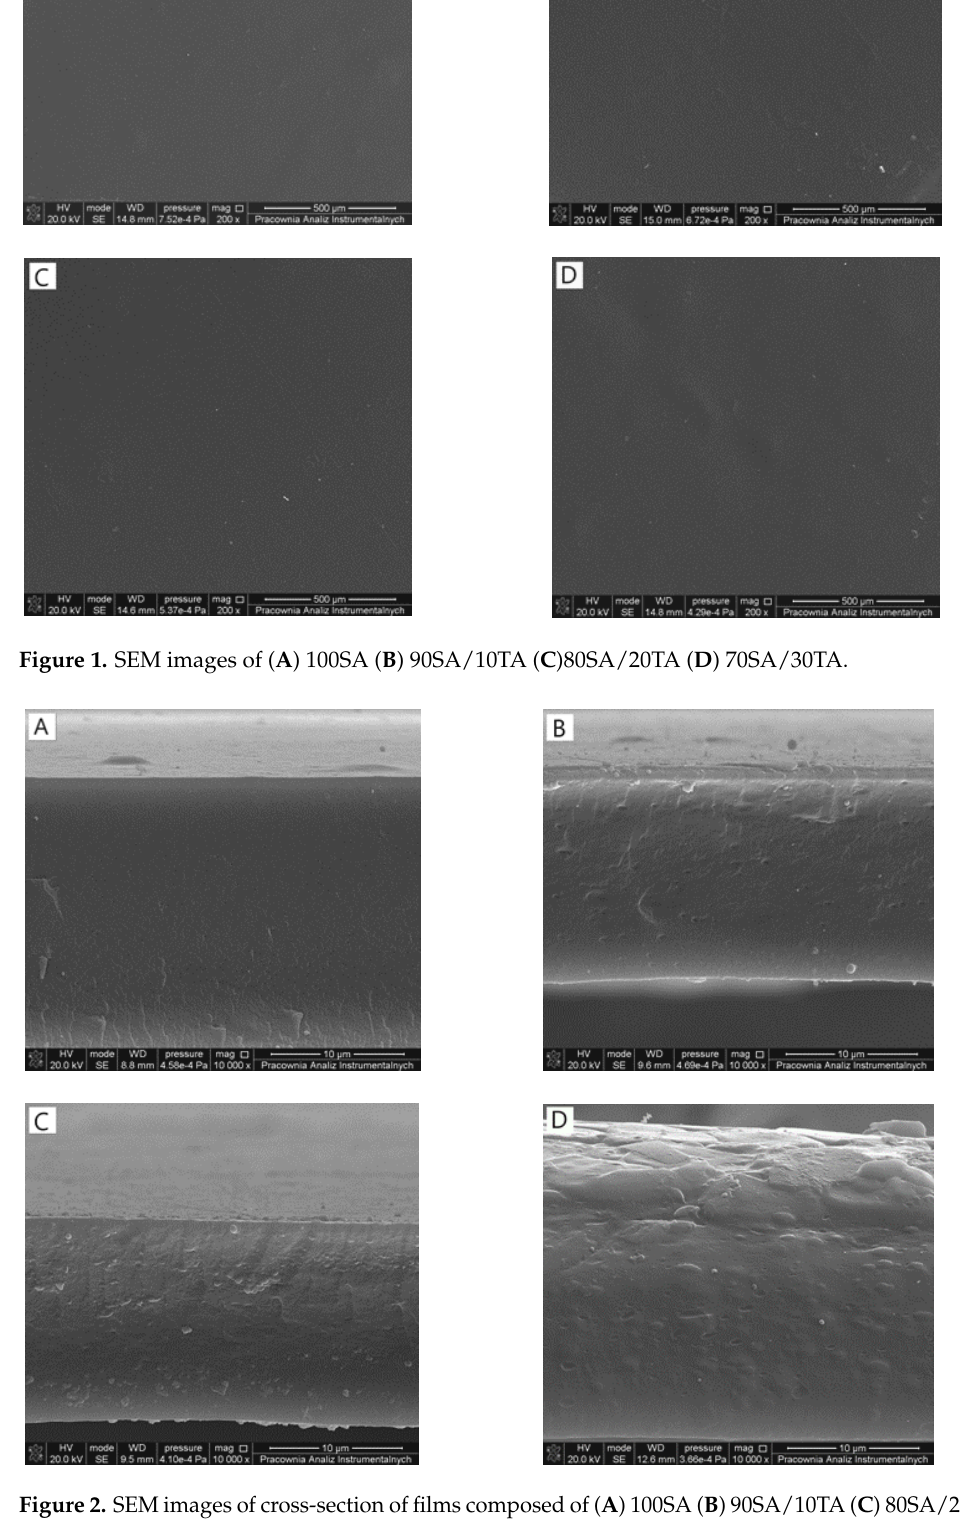
Figure 2. SEM images of cross-section of films composed of ( A ) 100SA ( B ) 90SA/10TA ( C ) 80SA/20TA ( D )